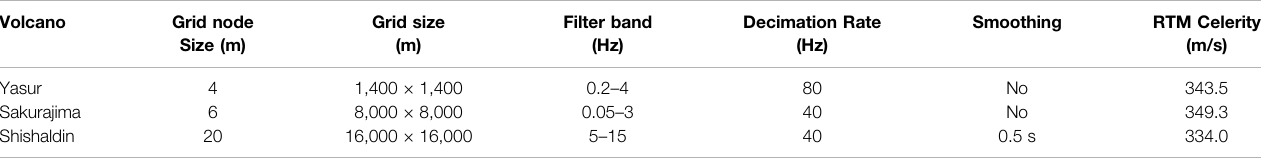
TABLE 1 | Grid and RTM processing parameters for each scenario. Volcano Grid node Grid size Size (m)